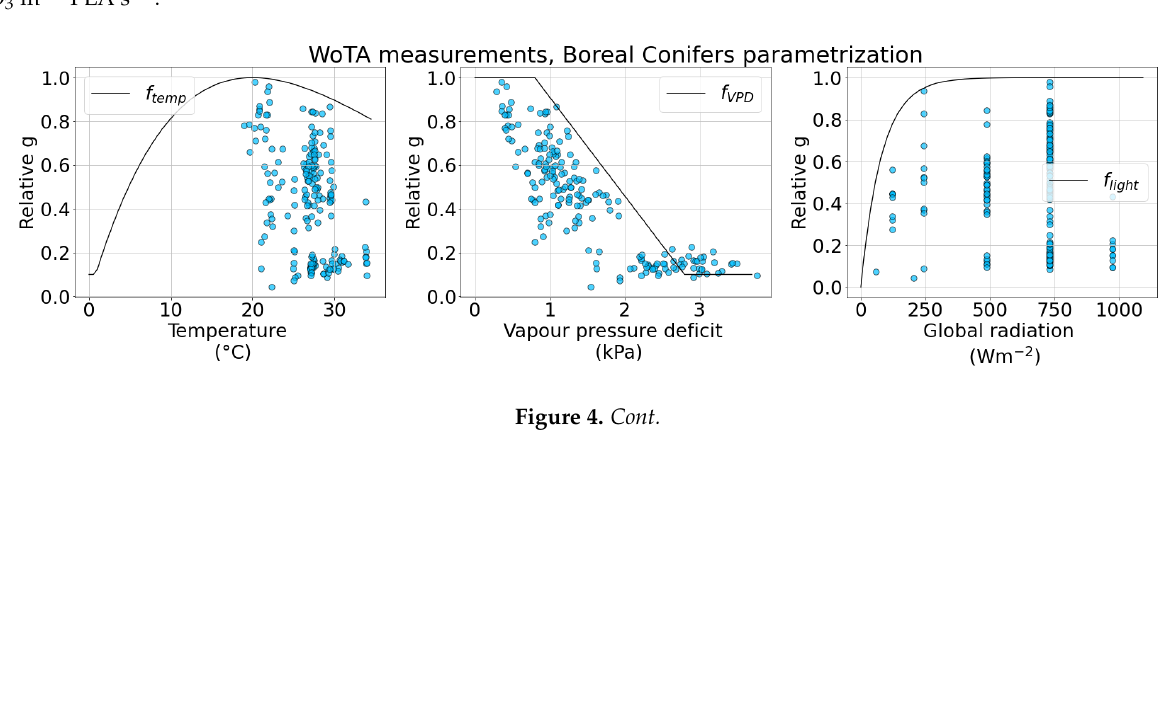
Figure 3. Comparison of stomatal conductances from LiCOR measurements and modeled conductance via the modified Jarvis model. Dataset of WoTA is examined on the upper plots and dataset of WTA on the lower plots. On the left side, the parameterization of boreal coniferous for WoTA and continental coniferous for WTA are examined, respectively. On the right side, the Jarvis model with the optimal set of parameters is evaluated. The used unit of stomatal conductance is µ mol O 3 m − 2 PLA s − 1